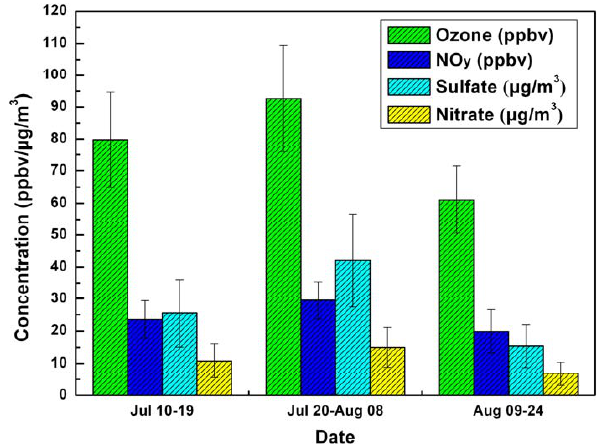
Figure 3. Average concentration of secondary pollutants at CRAES: ozone (for the Fig. 3. Average concentration of secondary pollutants at CRAES: 11:00-18:00 period), NO y , PM 2.5 sulfate and nitrate, during the three periods, namely ozone (for the 11:00–18:00 period), NO y , PM 2 . 5 sulfate and ni- trate, during the three periods, namely before the full control (10– before the full control (July 10-19), after the full control (July 20-August 8), and during 19 July), after the full control (20 July–8 August), and during the Olympics (9–24 August). Vertical bars are half standard deviations. the Olympics (August 9-24). Vertical bars are half standard deviations.